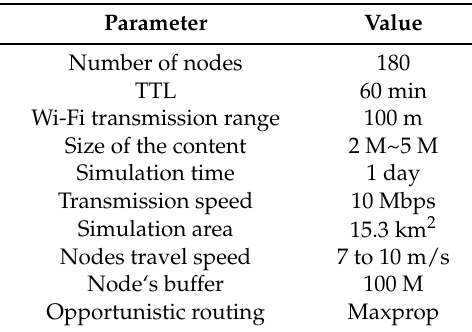
Table 1. The parameters in the